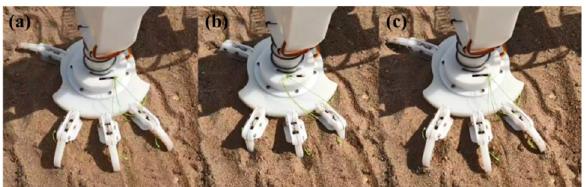
Figure 17. Toe grasping test. ( a ) Touching surface; ( b ) Grasping sands; ( c ) Retrieving to initial.